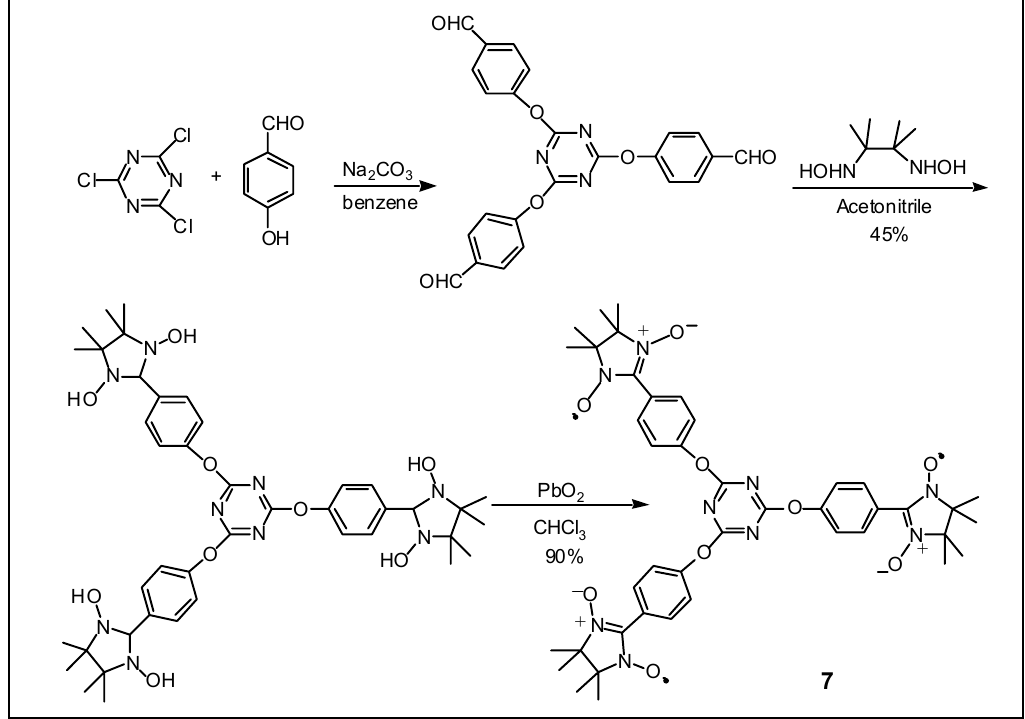
Scheme 6. Synthesis of the trisnitronyl nitroxide, 7